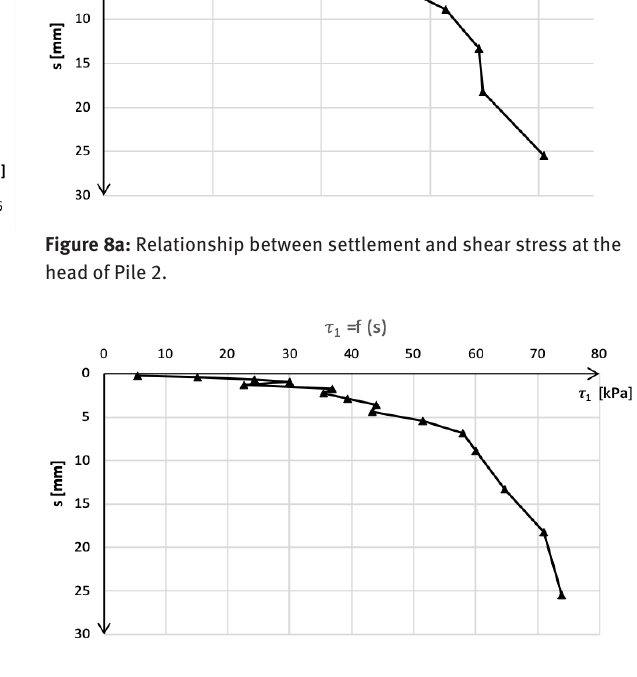
Figure 8b: Relationship between settlement and shear stress at the base of Pile